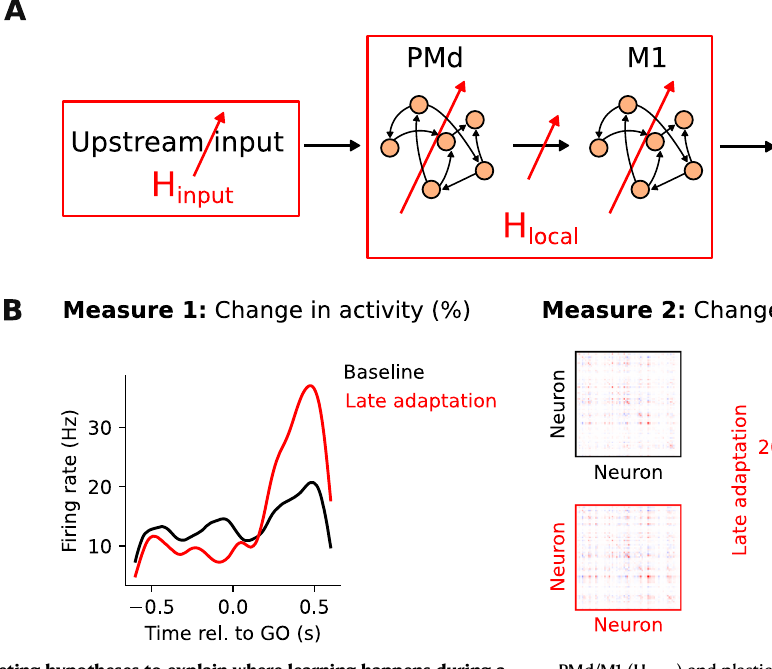
PMd/M1 (H input ) and plasticity within PMd/M1 (H local ). B Measures to quantify the changesinneuralactivityfollowingadaptation:(1)relativechangeintrial-averaged single neuron activity; (2) change in neural covariance. Both measures compare baselinetrialstolateadaptationtrials,aftermonkeyshadadaptedtothetask.Data from a representative session from Monkey